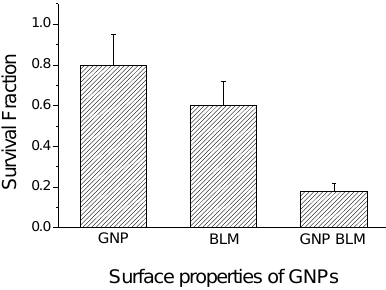
Figure 4. The long-term therapeutic efficacy of drug delivery using GNPs was measured using a clonogenic survival assay. The survival fraction of cells treated with GNP-BLM was lower compared to cells treated BLM alone ( n = 3).